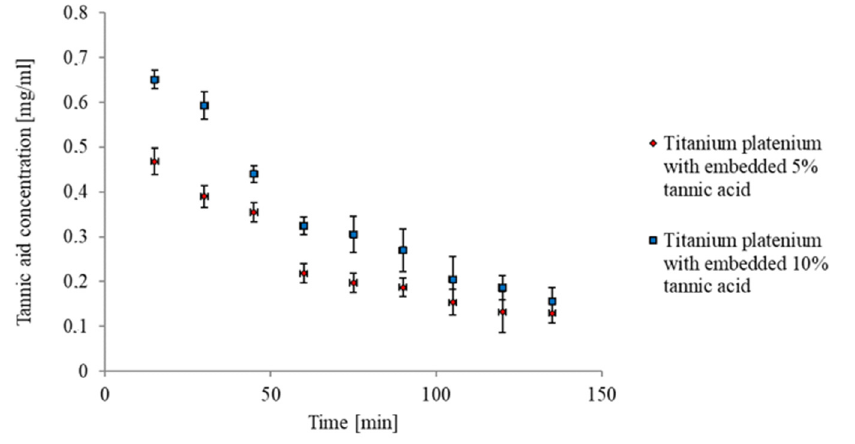
Figure 2. Total polyphenols released from titanium plates.